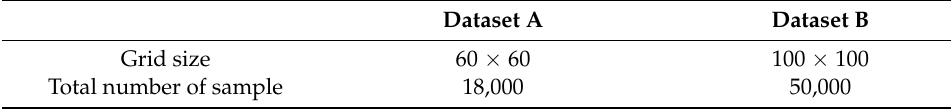
Table 2. Total dataset samples considered for the proposed ANN.